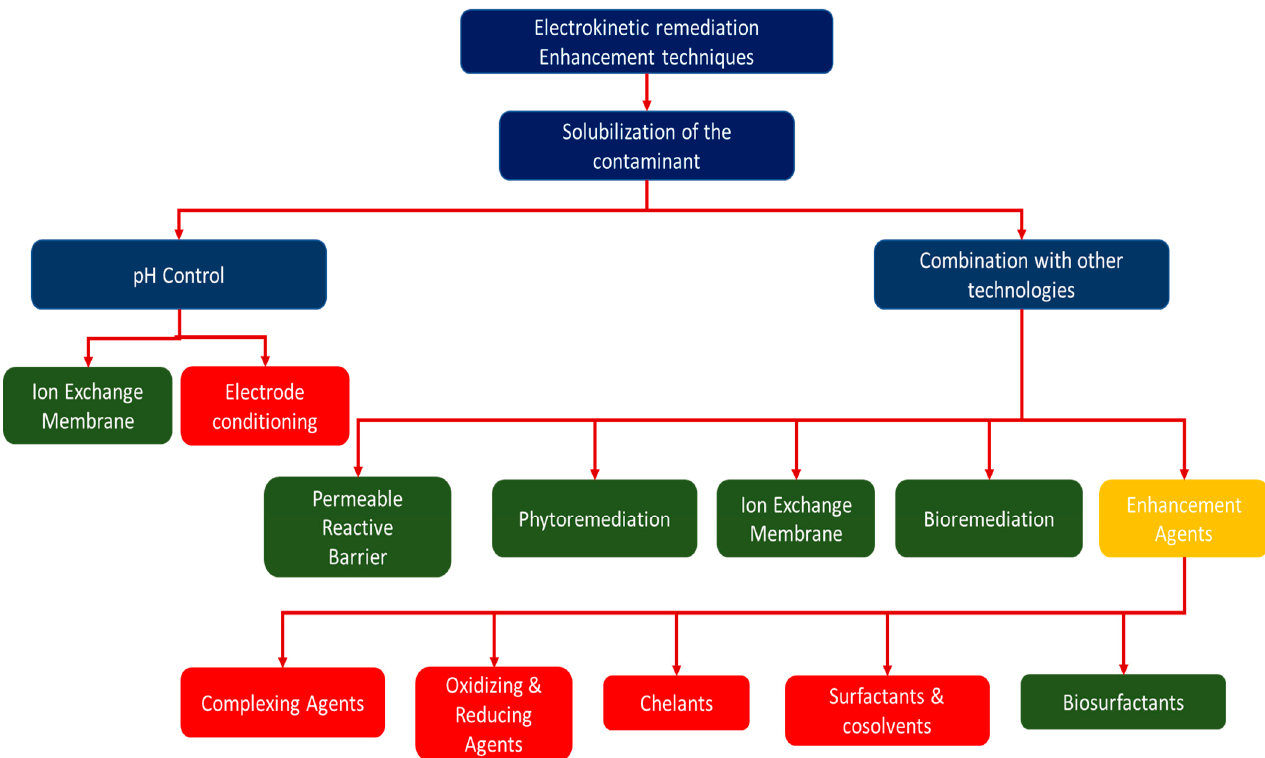
Figure 2. Technologies/techniques combined with electrokinetic remediation. Green represents the clean techniques, while red represents techniques that are regarded as environmentally unsound.